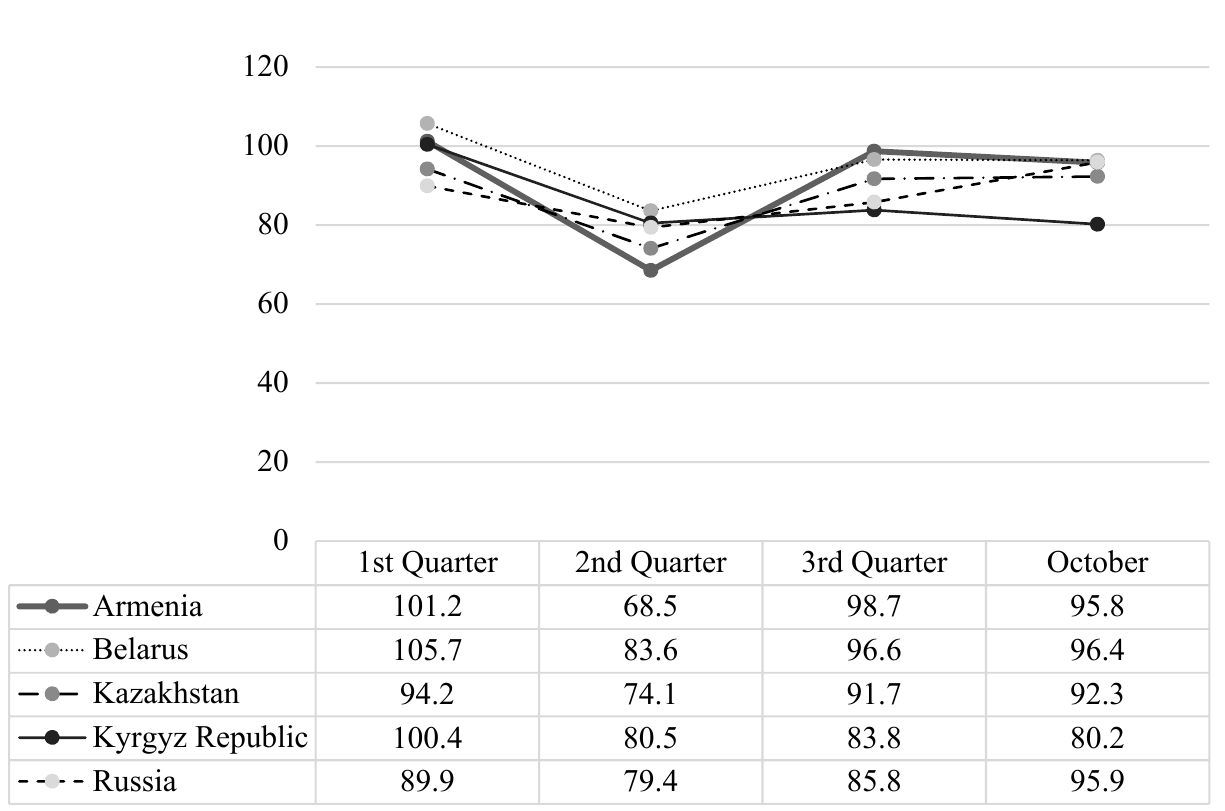
Figure 1. The pattern of changes in mutual trade between the EEU member States in 2020, as a percentage of the corresponding period of the previous year. Source: Compiled based on data from the Eurasian Economic Commission (2021a). Table 4. The structure and dynamic pattern of international trade based on imports and exports by the EEU member states both individually and across the integration